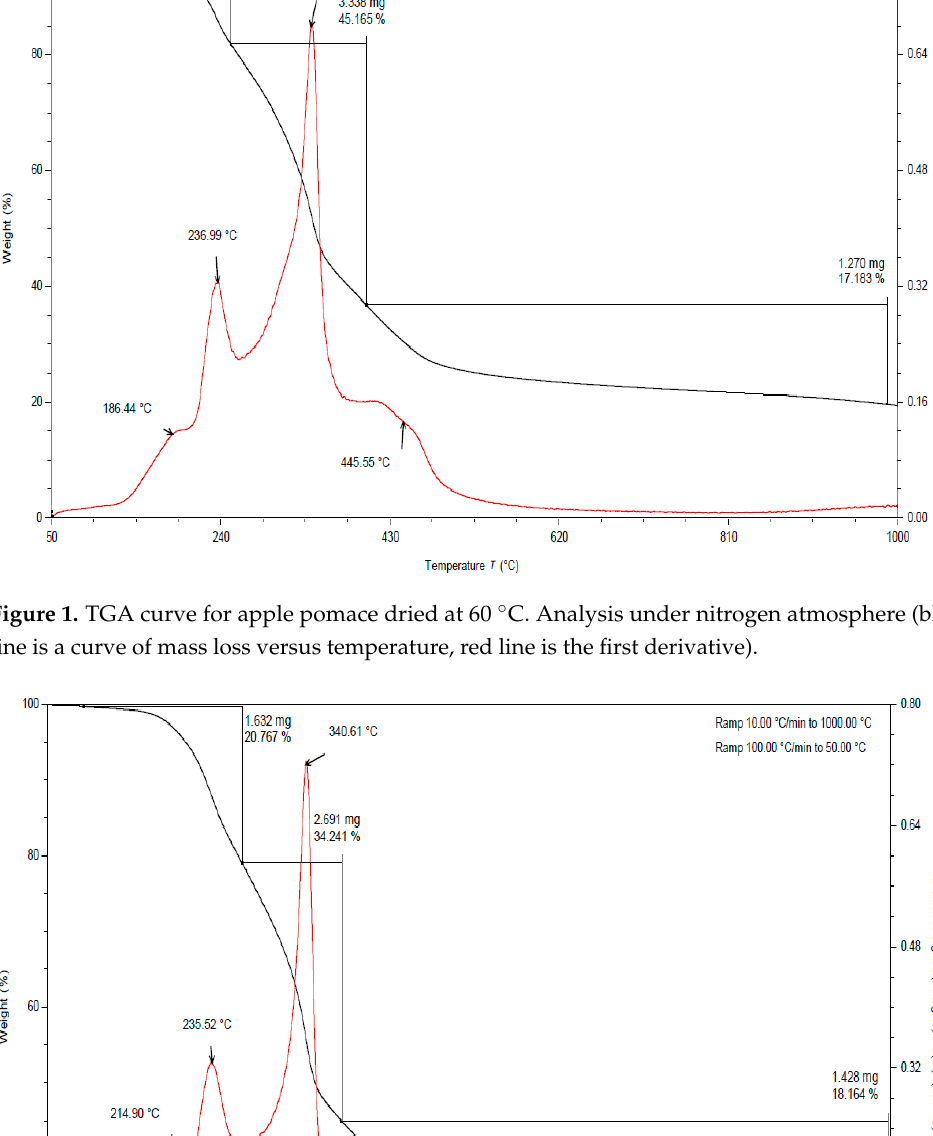
Figure 3. TGA curve for fresh apple pomace. Analysis in a nitrogen atmosphere (black line is a plot of mass loss versus temperature, red line is the first derivative). By analyzing the TGA curves obtained for the tested pomace, a quite distinct per- centage of weight loss was also observed, related to the degradation of hemicelluloses and pectins. Indeed, in this temperature range there are peaks characteristic of pectins and hemicelluloses with maxima ranging from 186 to 215 °C and 235 to 237 °C, respectively, when analyzed in the presence of nitrogen. The weight loss in this temperature range ranged from 18 to 23% (Table 2). For fresh pomace, only one peak was observed in this temperature range with a maximum of 235 °C.